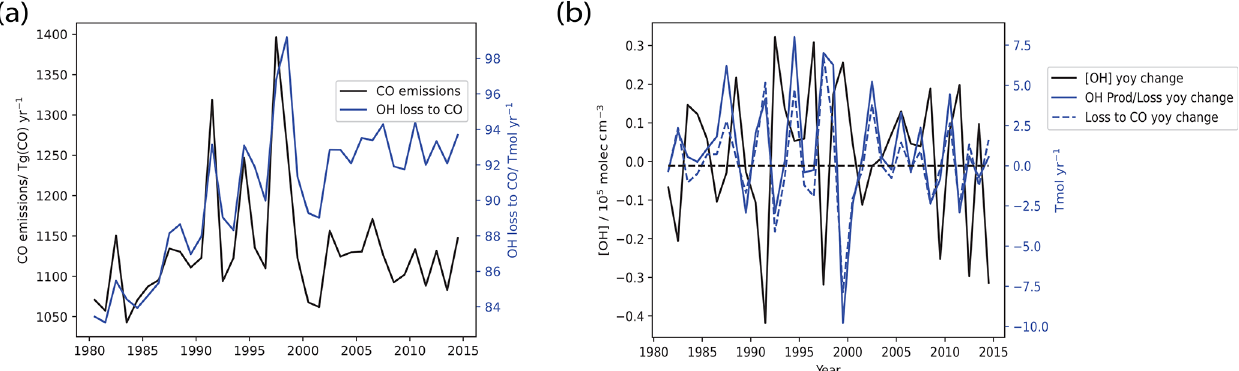
Figure 10. Plots of (a) OH loss to CO with CO emissions, and (b) the year-on-year changes in [OH] together with the year-on-year changes in net OH production and those of OH loss to CO. As seen in panel (a) , CO emissions are positively correlated with OH loss to CO in the Base run ( r = 0 . 69). This thereafter drives overall IAV in total loss and production. As seen in panel (b) , we see that OH year-on-year production or loss change (solid blue) is highly correlated with that of the OH loss to CO (dotted blue) with r = 0 . 94, suggesting that the OH loss to CO is indeed driving the IAV seen in total production or loss. The year-on-year change in production or loss is in turn anti-correlated with the year-on-year change in OH, with r = − 0 .